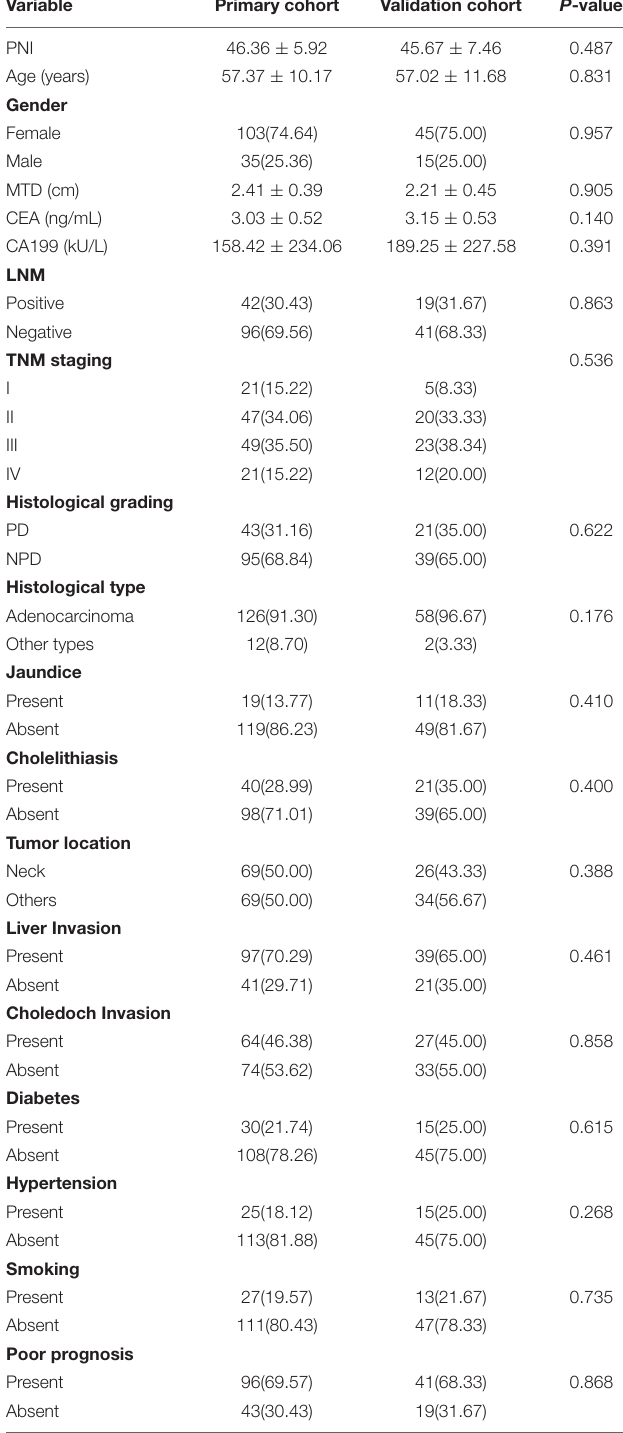
TABLE 1 | Baseline characteristics of study